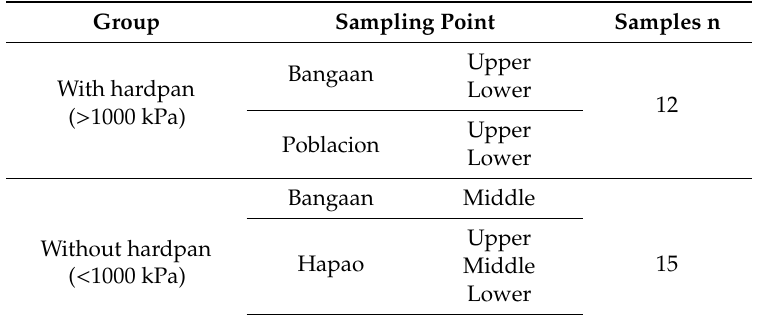
Table 2. Statistical classification of the sampling site by hardpan formation. Group Sampling Point Samples n